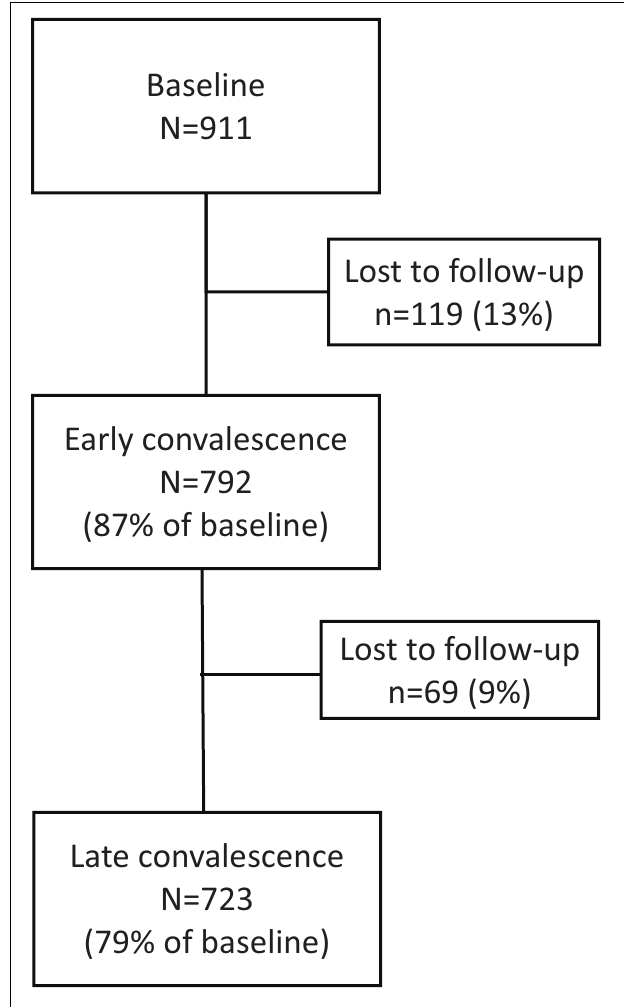
FIGURE 1 | Flow of patients through the study from baseline to late